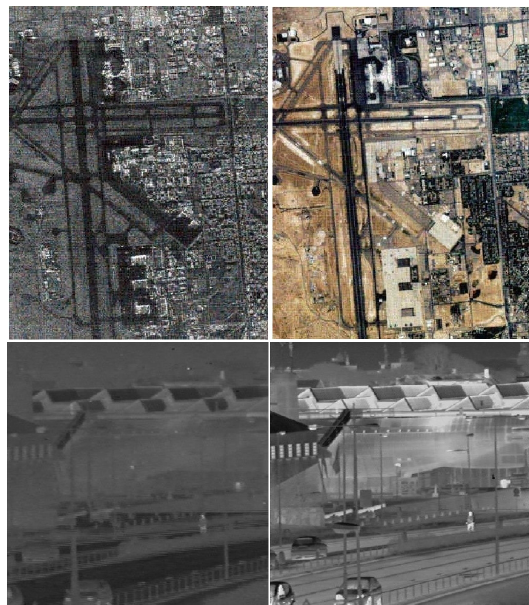
Figure 4. The raw image pair of SAR & Visible and Infrared& Visible light Figure 6. The images with different SNRs. The values of SNRs are 5.1728 and -0.0007 from left to right.